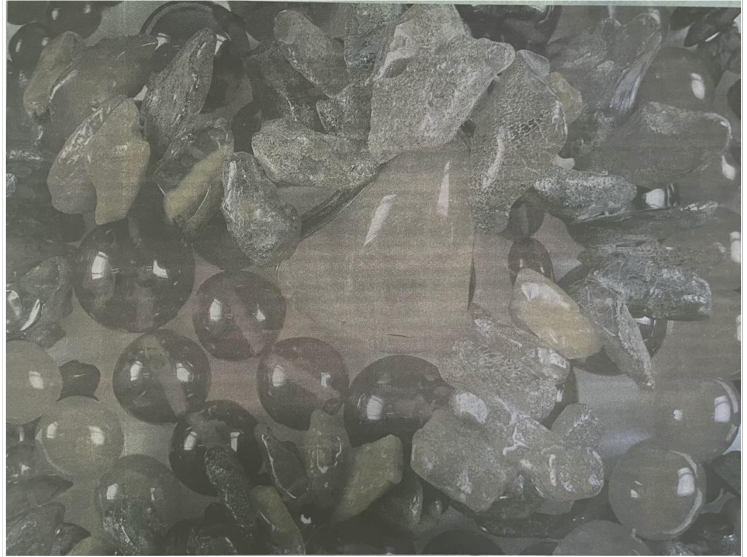
Figure A11. 25LPI, offset litho, Spectraval™ pigments, R = 2 × pass, G = 3 × pass, B = 4 × pass black Plike, film negative, print size: 600 mm × 450